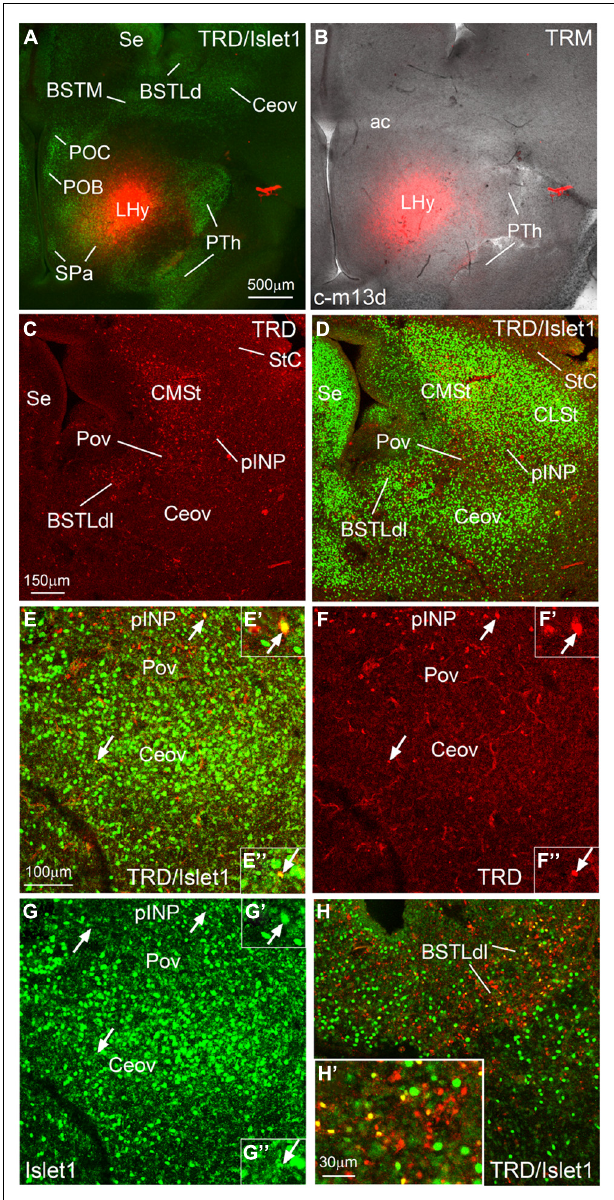
FIGURE 9 | Representative case of an in vitro tract-tracing assay, using the fluorescent axonal tracerTexas Red-conjugated dextran amine. (A–H) Digital images from an organotypic culture of a telencephalic oblique-horizontal slice of a chicken embryo (c-M13, right hemisphere), passing through the alar hypothalamus and caudal telencephalon (at central amygdalar levels), in which the axonal tracer (TRD; red) was centered in the LHy, including the lateral parts of the SPV and the subparaventricular or SPa domains.To better understand the location of the tracer application and the retrograde labeling, the slice was immunostained to detect Islet1 (A,D,E,G,H) . Many retrogradely labeled cells were seen in the BSTLdl, the Pov, the peri-INP island field (pINP), the CMSt, and the StC. A few cells were also observed in the oval central nucleus. Some of the retrogradely labeled cells colocalized Islet1 (see arrows and details in (E (cid:2) ,F (cid:2) ,G (cid:2) ) for pINP; (E (cid:2)(cid:2) ,F (cid:2)(cid:2) ,G (cid:2)(cid:2) ) for Ceov; (H (cid:2) ) for BSTLdl). See text for more details. For abbreviations, see list. Scale bars: A = 500 μ m (applies to A,B ); C = 150 μ m (applies to C,D ); E = 100 μ m (applies to E,H ); H (cid:2) = 30 μ m (applies to E (cid:2) –H (cid:2) ,E (cid:2)(cid:2) –G (cid:2)(cid:2) ,H (cid:2) ).